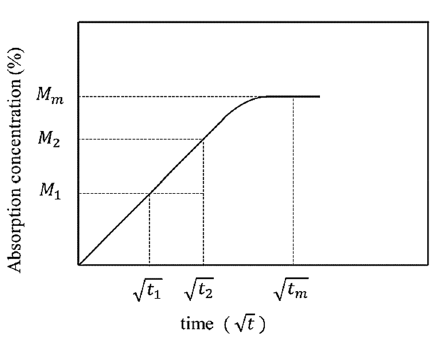
Figure 3. Water absorption curve according to Fick’s laws of